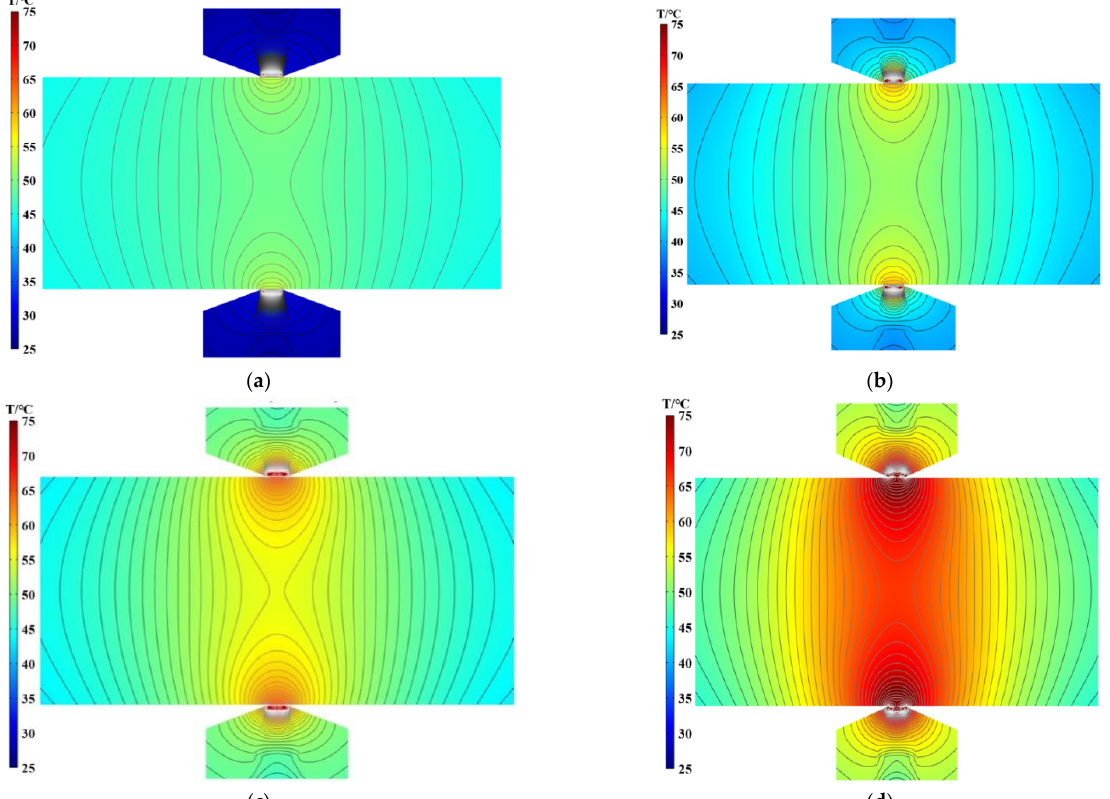
Figure 9. Temperature cloud of the MR fluid seal under different speed conditions with H ≠ 0: ( a ) 300 rpm; ( b ) 600 rpm; ( c ) 900 rpm; and ( d ) 1500 rpm.